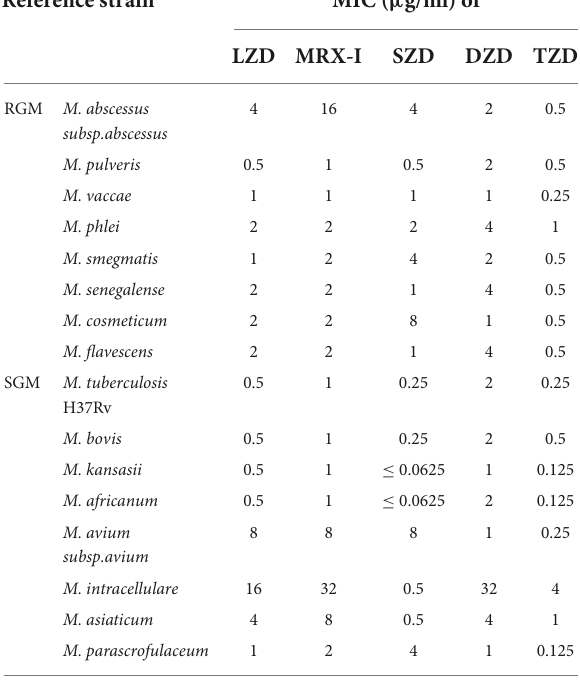
TABLE 1 MICs of the five oxazolidinones against mycobacterial reference strains.